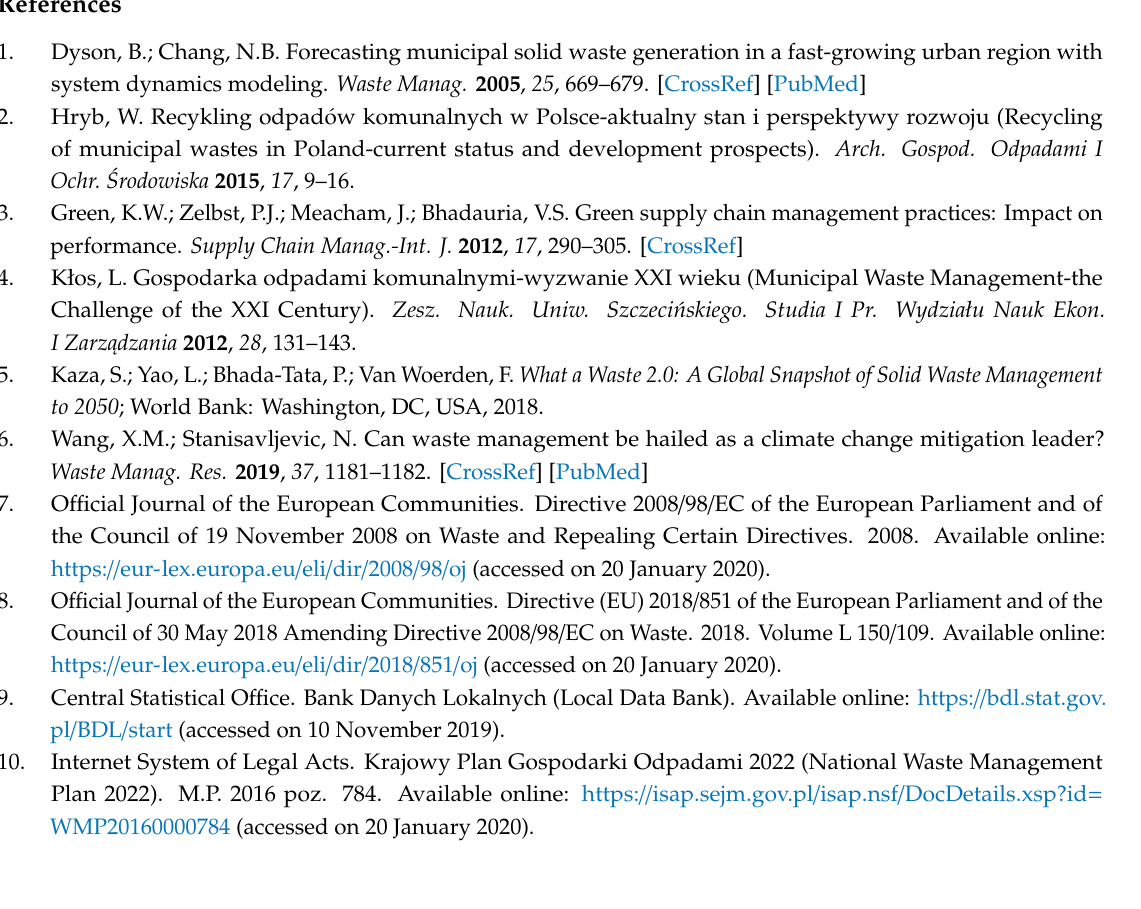
Figure S1: The administrative division of Poland, Table S1: The values of the location quotients ( LQ ) for selected waste in comparison with all municipal waste in counties in Poland, Table S2: The values of the location quotients (LQ) for the analyzed fractions of selected waste in comparison with all selected waste in counties in